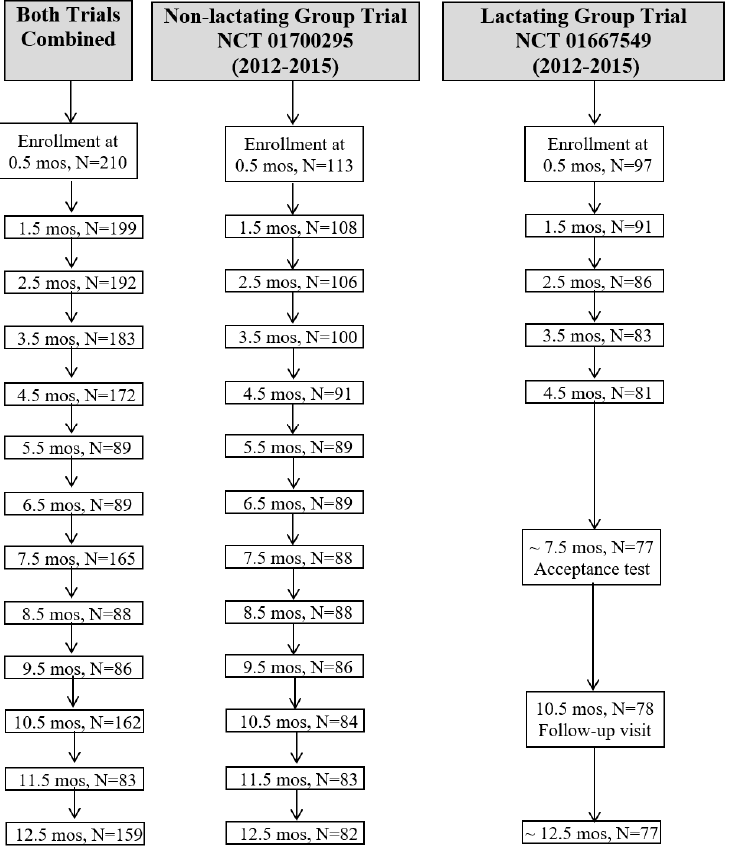
Figure A1. Flow of participants in both trials combined or in the trial on non-lactating mothers only (NCT 01700295; 2012–2016) or lactating mothers only (NCT 01667549; 2012–2015).